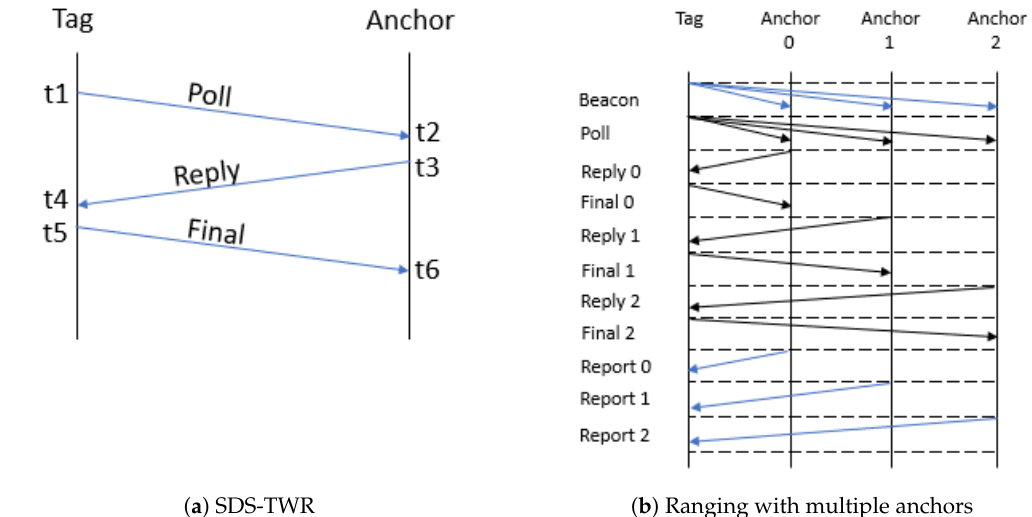
Figure 6. Ranging. SDS-TWR, symmetric double-sided-two way